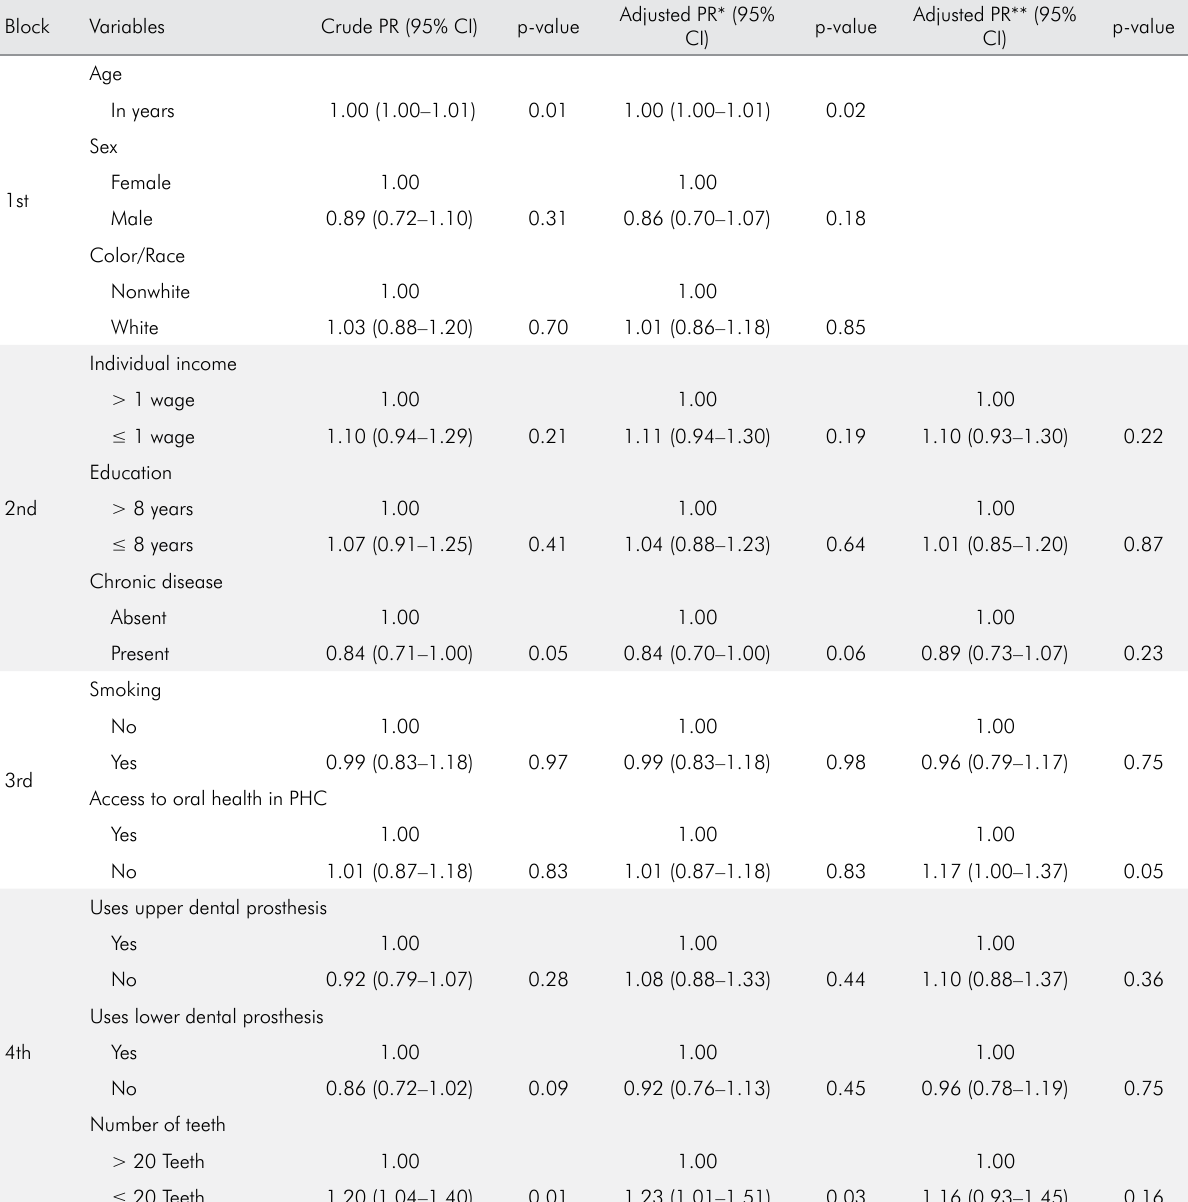
Table 3. Hierarchical analysis – impact on the oral health-related quality of life